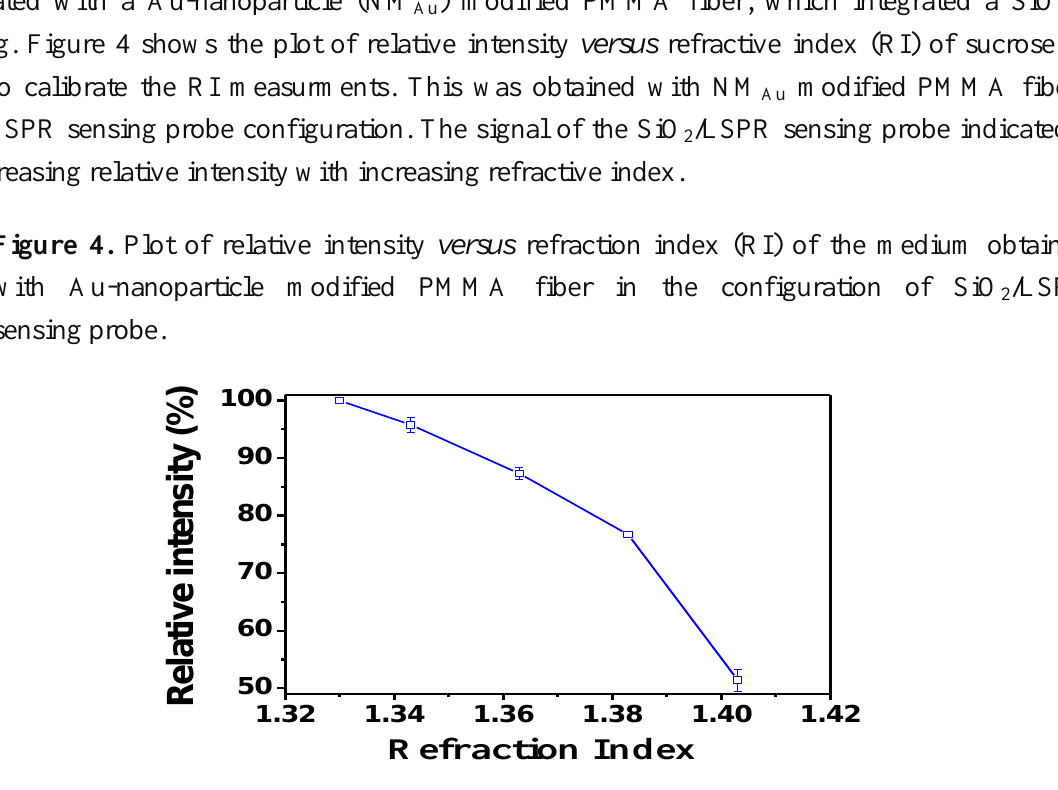
/LSPR sensing probe to ( a ) deionized water and ( b ) 2 had a diameter of 4.5 mm, at R = 10, in pH = 4 2